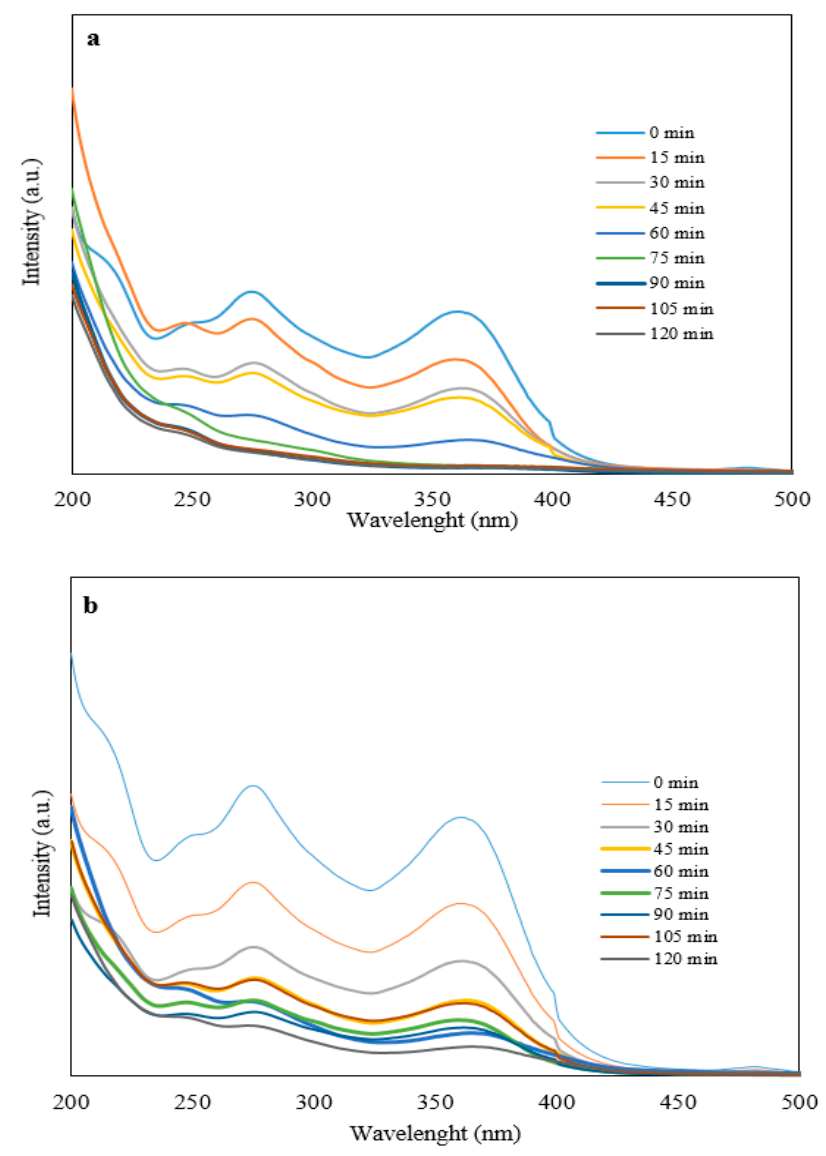
Figure 7. Photocatalytic degradation of tetracycline under visible-light irradiation using the ( a ) di- genite and ( b ) covellite phases of copper sulfide.